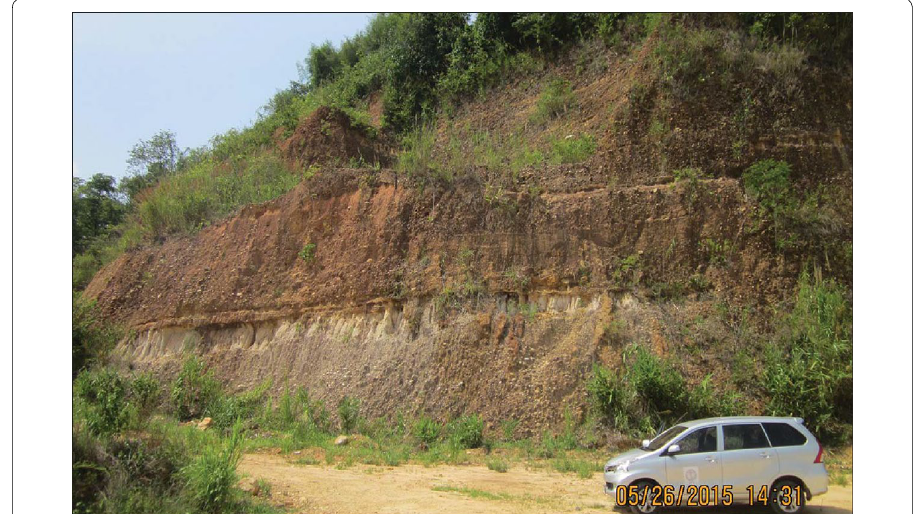
Fig. 17 Horizontal clayey, sandy gravel of the Mae Taeng Formation. Subround clasts are entirely quartzitic sandstone with veinlets of quartz up to 40 cm diameter. Quarry wall is ~60 m high, comprised of a lower 4 m of clayey sandy boulder gravel, 1.5 m of sand, 4 m of fining upward sandy boulder gravel with a sandy top, and 8 m of clayey boulder gravel. Upper 40 m poorly exposed clayey, sandy gravel. Location is along the Huai Ton Pheung Road, 0.5 km NW of Ban Ton Pheung, (516322E,